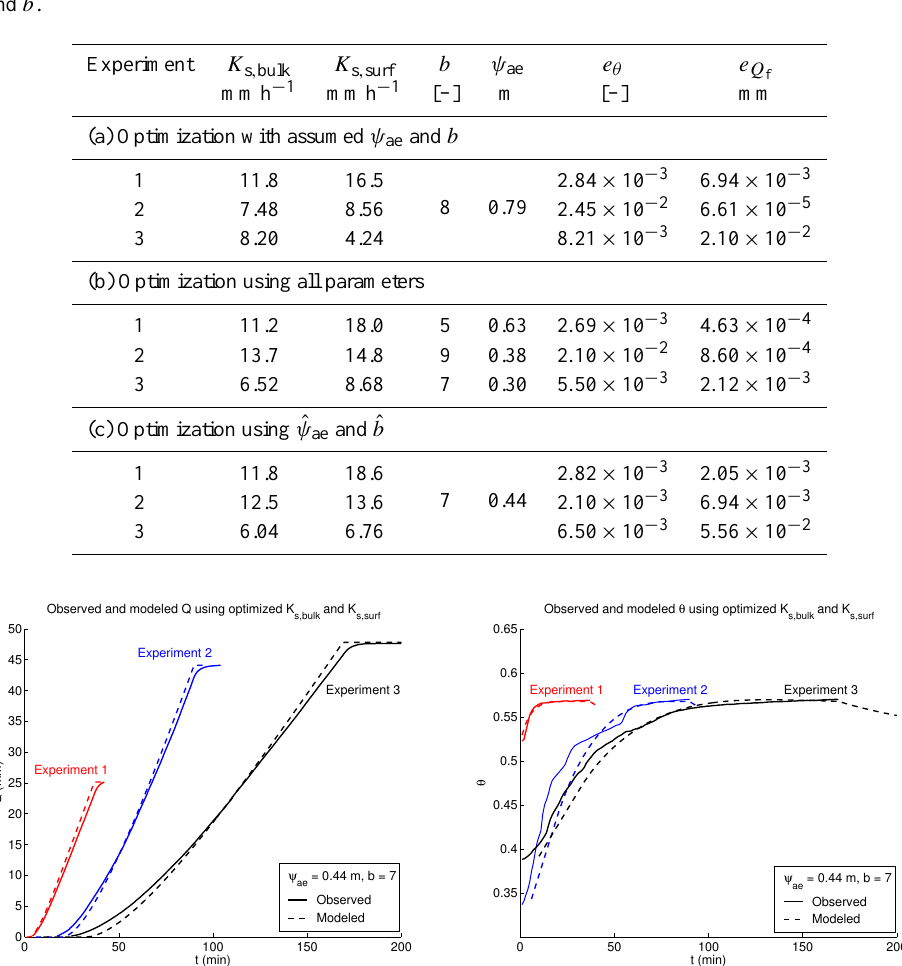
Table 4. Parameters for the model optimization (a) using assumed values of b and ψ ae , (b) including all four parameters in the optimization, and (c) using ˆ ψ ae and ˆ b .